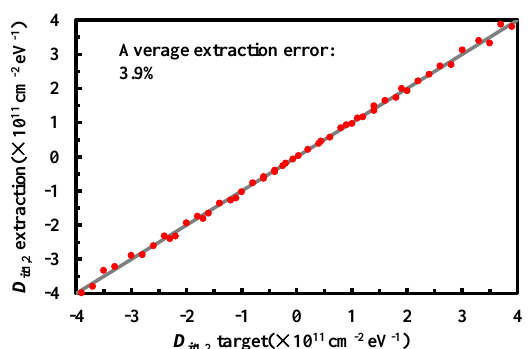
Average extraction error: 3.9%